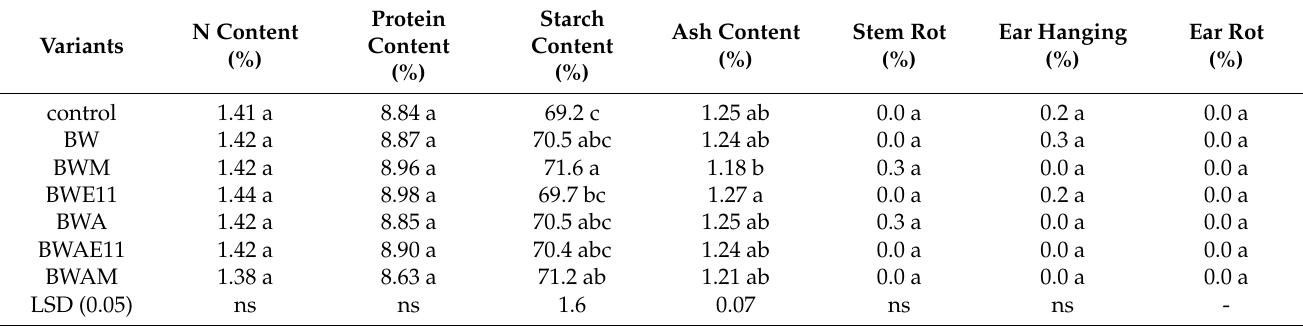
Table 5. The influence of the applied preparations on selected chemical properties of maize seeds and stem and cob fusariosis.